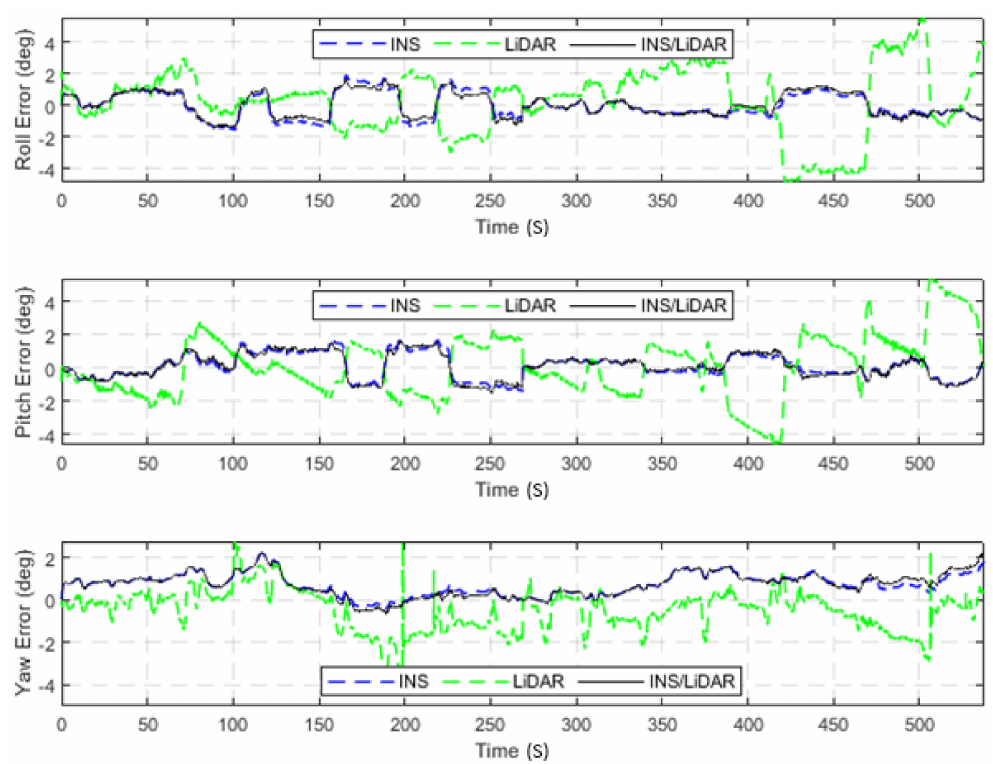
Figure 22. D-28—GNSS-assisted: errors of attitude angles (roll, pitch, and